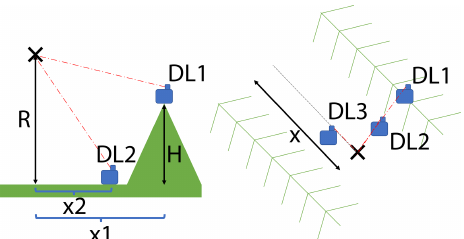
Figure 3. Idealized setup to examine the errors associated with ne- glecting the vertical velocity and only producing 2D virtual towers. The setup is meant to closely mimic the positions of the CLAMPS DL, DLR no. 1, and DLR no. 2 used in the 3D virtual tower. DL3 is varied along x to simulate different elevation